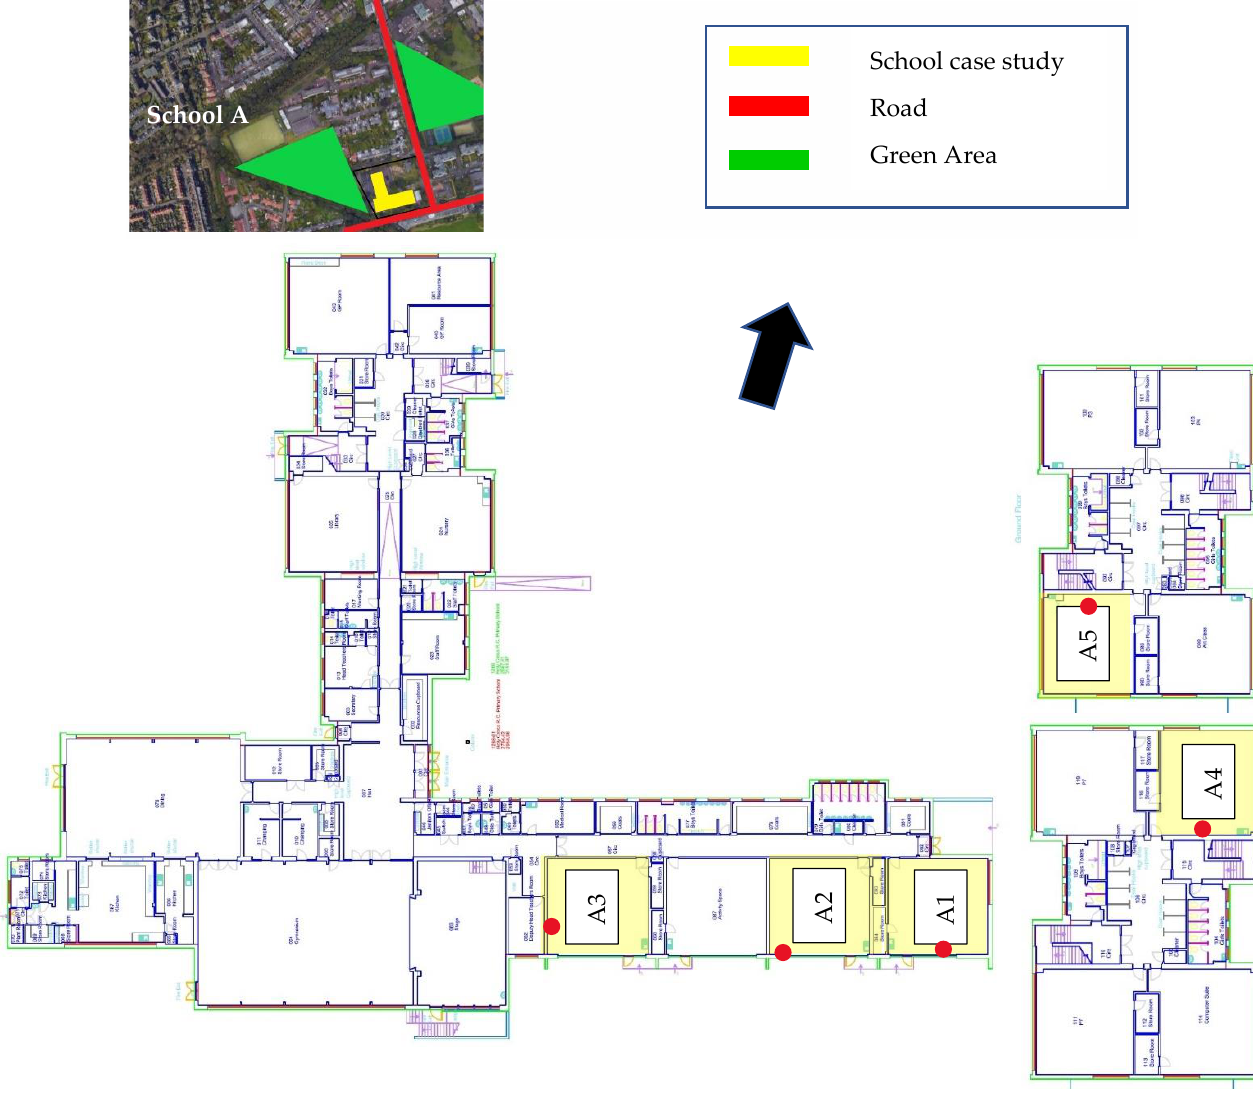
Figure 1. School A. Figure 1. School A.